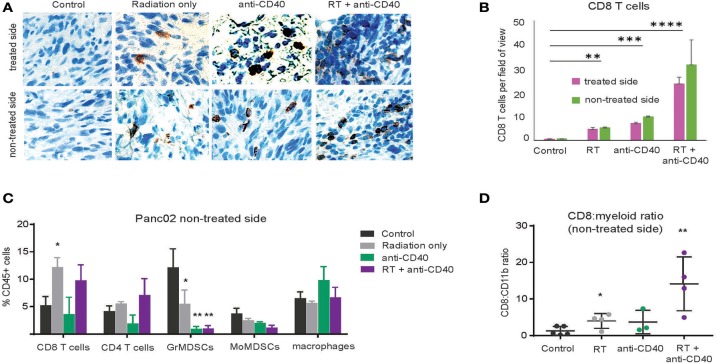
Combination RT and anti-CD40 leads to increased intratumoral CD8 T cells. (A) Tumors from mice treated with 5Gy SBRT and/or a single dose of anti-CD40 (20 μg) were harvested at 2 weeks post-treatment and analyzed by immunohistochemistry for CD8. (B) Quantification of a. n = 5 mice/group. (C) Tumors from mice treated as in Figure 2 were harvested at 2 weeks post-treatment, digested and analyzed by flow cytometry. GrMDSCs: CD11b+Gr1high; MoMDSCs: CD11b+Ly6C+; macrophages: CD11b+,Gr1−. (D) Ratio of CD8 T cells to total CD11b+ myeloid cells. n = 5 mice/group. Error bars are SD. *p < 0.05, **p < 0.01, ***p < 0.001, ****p < 0.0001.